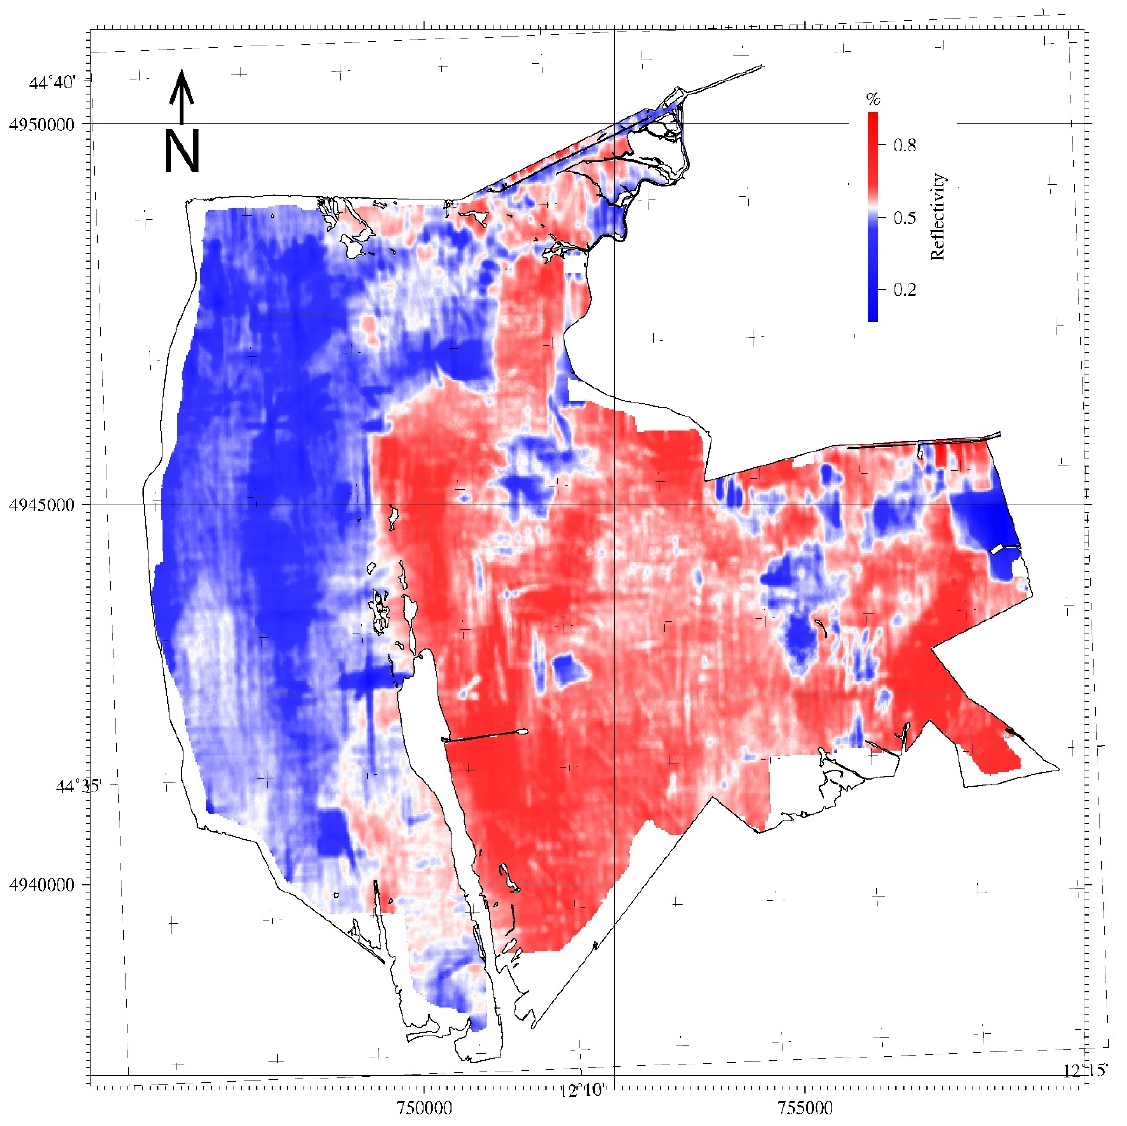
Figure 9. Normalized lagoon-floor reflectivity map of the Valli di Comacchio. Reflectivity is displayed using a color palette ranging from red (high values) to blue (low values). Projection UTM 32N.